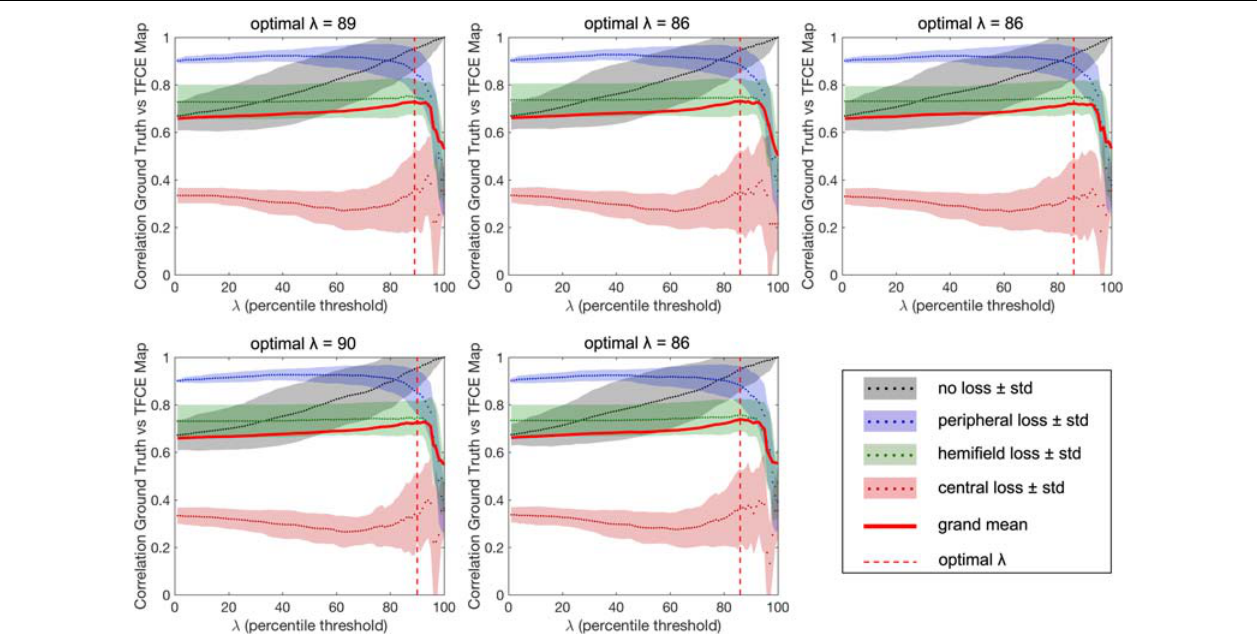
FIGURE 6 | Results of the optimization of the λ parameter for each fold of the cross-validation. The optimal percentiles to be used as thresholds between “healthy” and “impaired” TFCE values are in the range 86th–90th (mean 87.4), corresponding to the peaks of the grand average between all tested conditions.